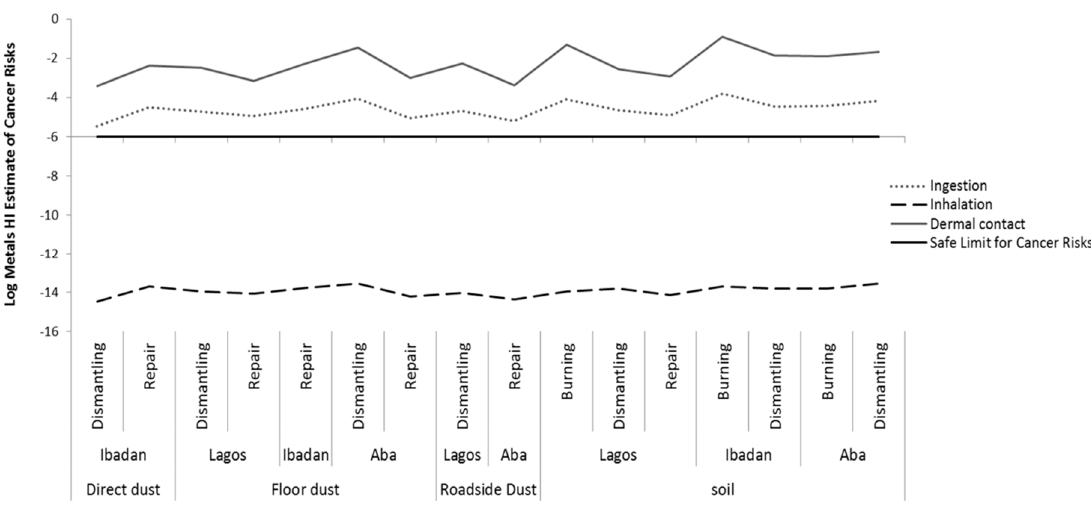
Figure 7. Hazard index (HI) for cancer risk via ingestion and dermal contact of metals in soil and dust at various e -waste sites in the three locations.